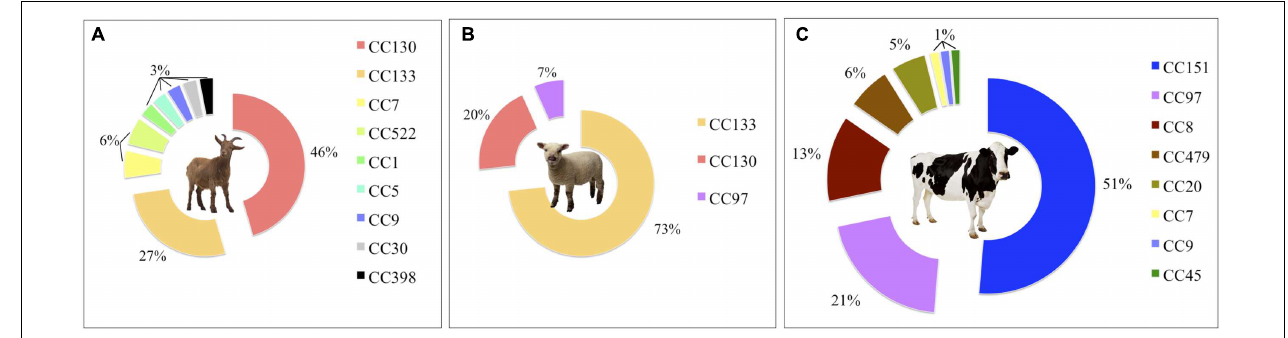
FIGURE 1 | Distribution of clonal complexes (CC) among Staphylococcus aureus isolated from the milk of different animal species: (A) goat ( n = 34, pink), (B) sheep ( n = 15, blue), (C) cows ( n = 78, green).